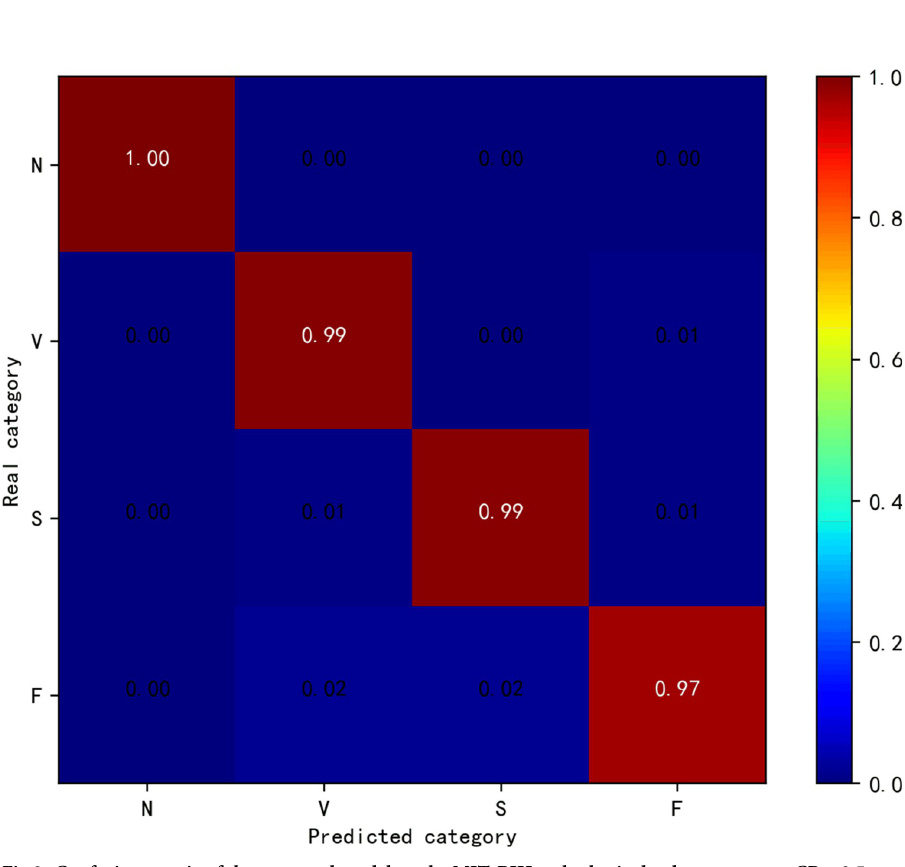
Fig 9. Confusion matrix of the proposed model on the MIT-BIH arrhythmia database test set at CR = 0.5.